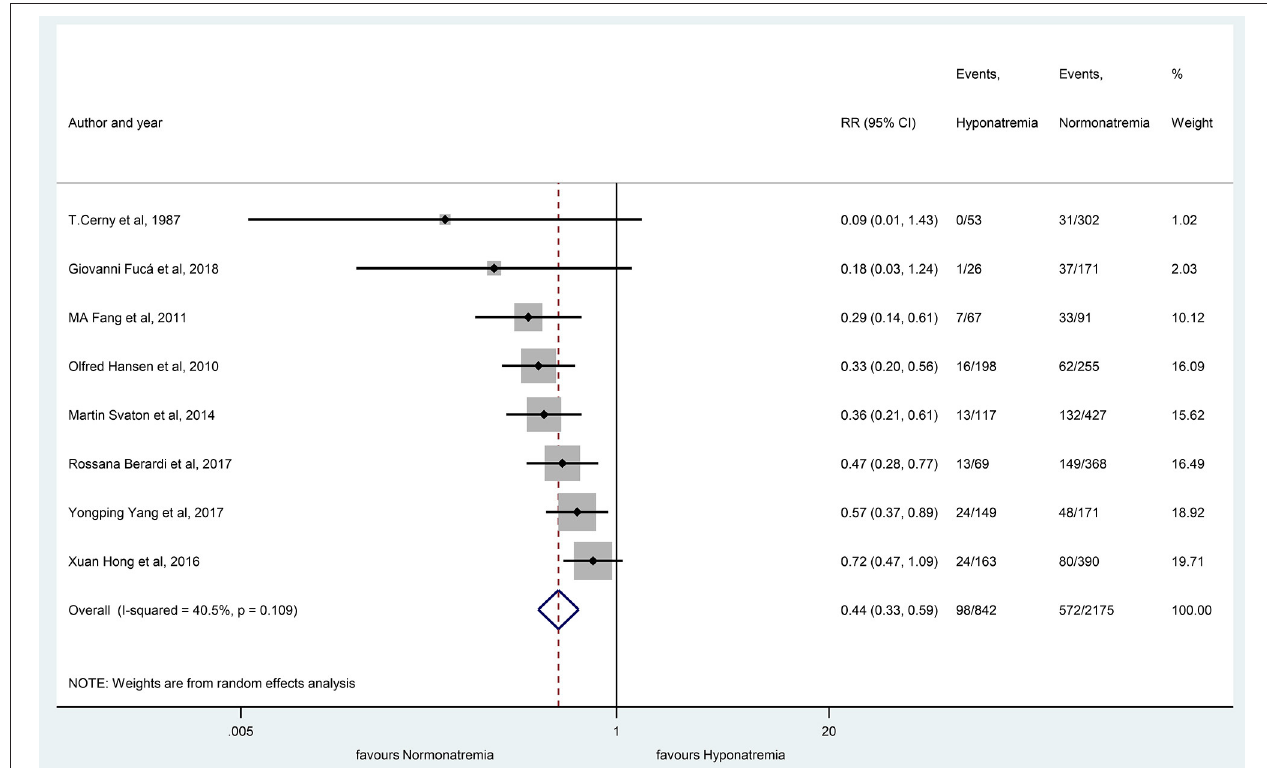
FIGURE 8 | The overall survival rates at 20 months, comparing patients with hyponatremic and normonatremic lung cancer. Black diamonds represent the individual effects of studies, and vertical lines show the corresponding 95% CI. The size of the gray squares reflects the individual weight of a particular study. The blue diamond shows the overall or summary effect. The outer edges of the diamonds represent the CIs. RR, risk